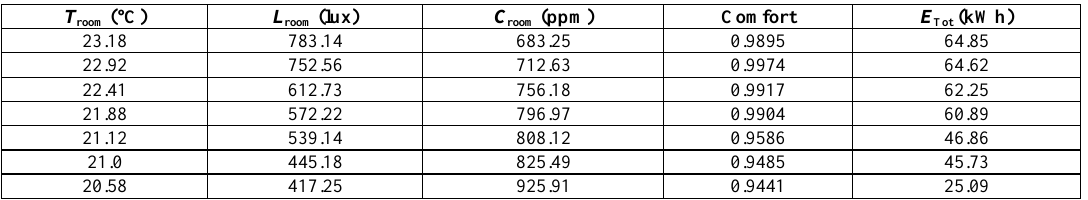
Table 2. Solutions with optimal values of decision